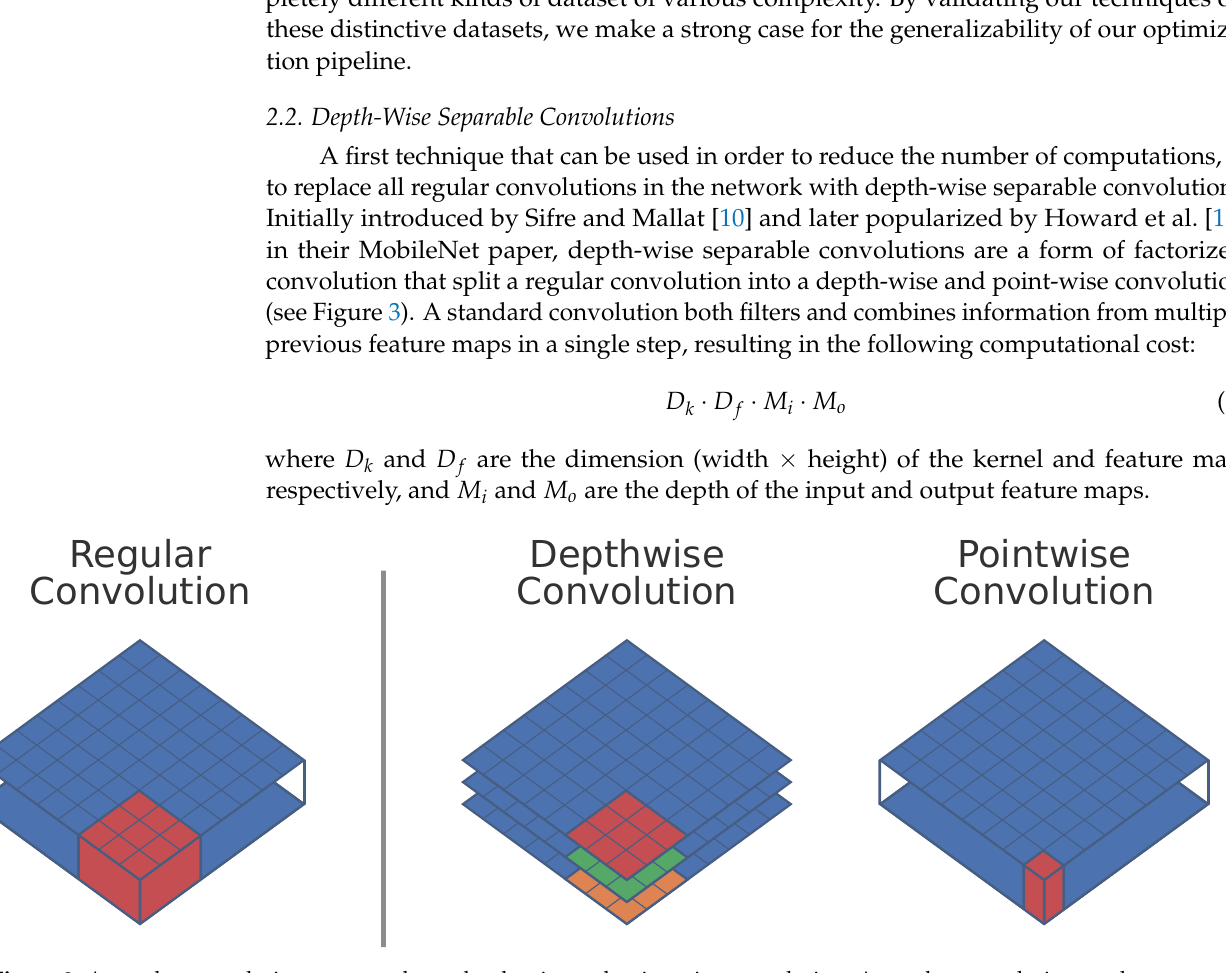
Figure 3. A regular convolution compared to a depth-wise and point-wise convolution. A regular convolution can be seen as a volumetric operation, whilst the depth-wise separable convolution can be considered as a sum of two 2D